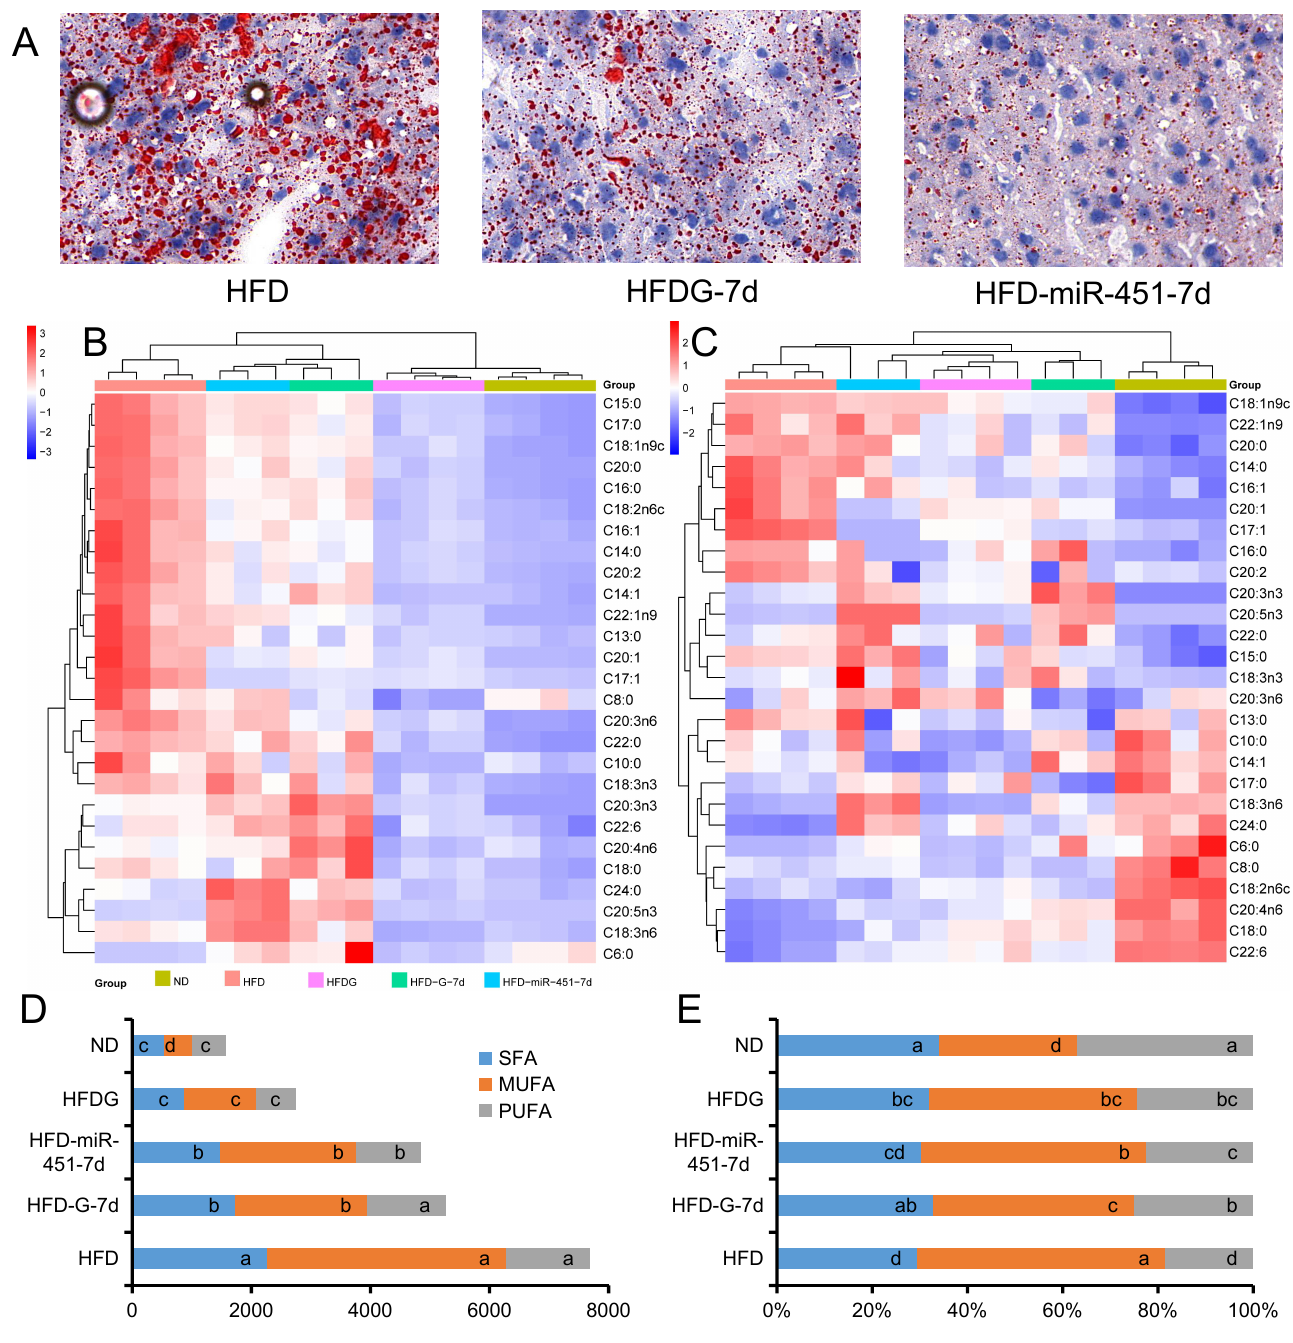
Figure 5. Effects of genistein and miR-451agomir on fatty acid content and composition in mouse liver. ( A ) Oil Red O staining of liver sections (magnification, 200 × ). ( B ) Cluster heatmap of the content of different fatty acids in the liver. ( C ) Cluster heatmap of different fatty acid composition of liver. ( D ) Saturated fatty acid (SFA), monounsaturated fatty acid (MUFA) and polyunsaturated fatty acid (PUFA) content in liver. ( E ) Composition of SFA, MUFA and PUFA in liver. The group of ND, HFD and HFDG, n = 4; the group of HFD-G-7d and HFD-miR-451-7d, n = 3. Different superscript letters indicate significant differences ( p ≤ 0.05), and the same superscript letters indicate insignificant differences ( p >